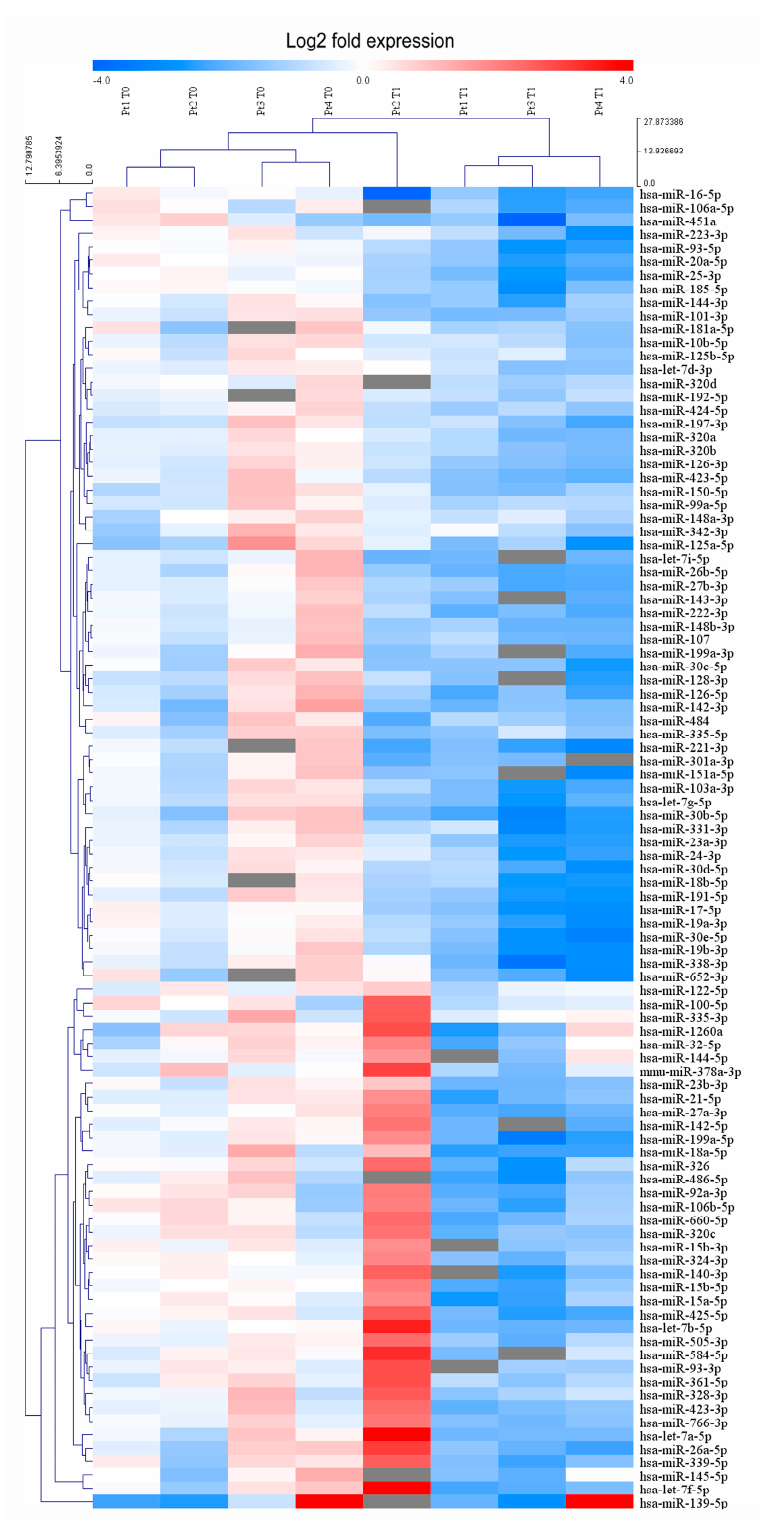
Figure 3. Serum miRNAs profiling of patients at baseline (T0) and after treatment (T3). Heatmap displaying the results of a hierarchical cluster analysis (HCA) conducted on the patients’ serum levels of a 98 miRNAs panel at baseline and after the end of the treatment. Log2 fold expression values of reference are reported in the upper bars.